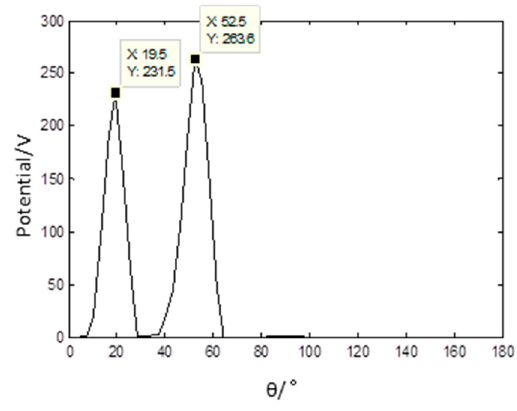
Figure 13. Potential function of sparse signals based on wavelet transform.